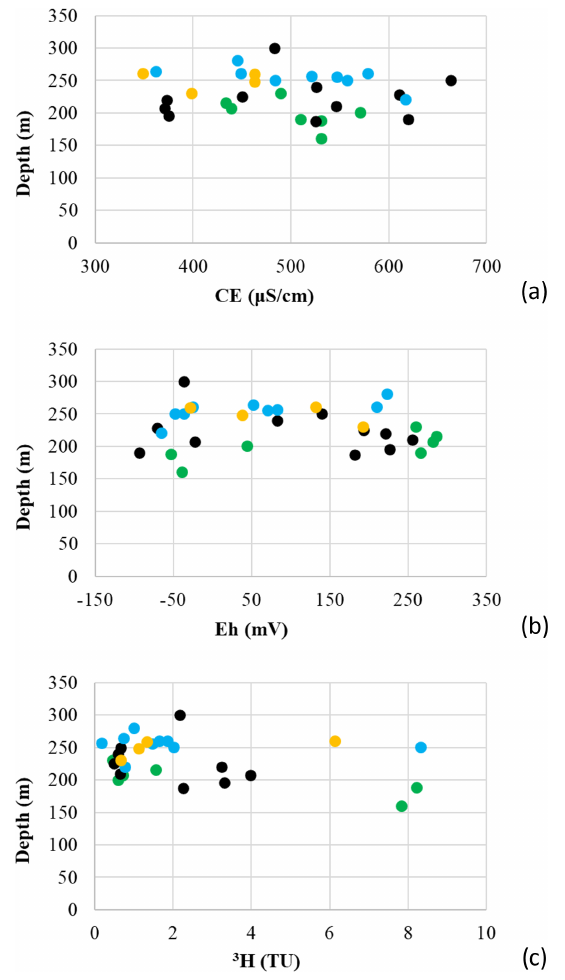
Figure 4. Correlation between (a) wells depth (m) and electrical conductivity (µScm − 1 ); (b) wells depth (m) and redox potential (mV); (c) wells depth (m) and 3 H value (TU) of each samples anal- ysed. Coloured in green the samples form Quinto di Treviso, in black samples from Treviso, in light blue samples from Preganziol and in yellow samples from